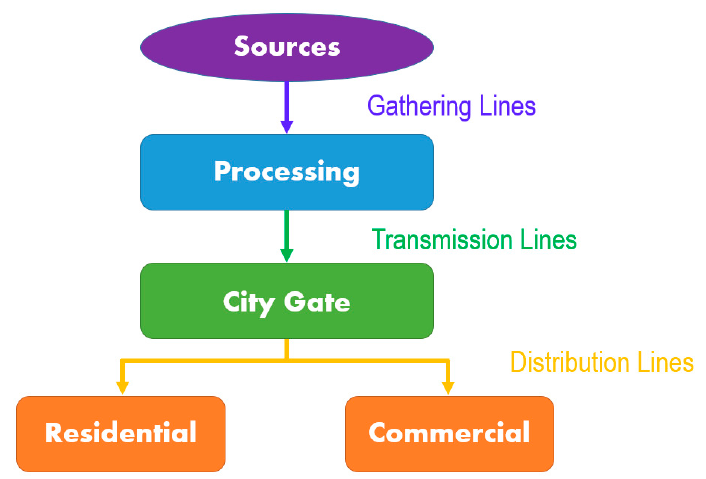
Figure 4. Natural gas pipeline network diagram.